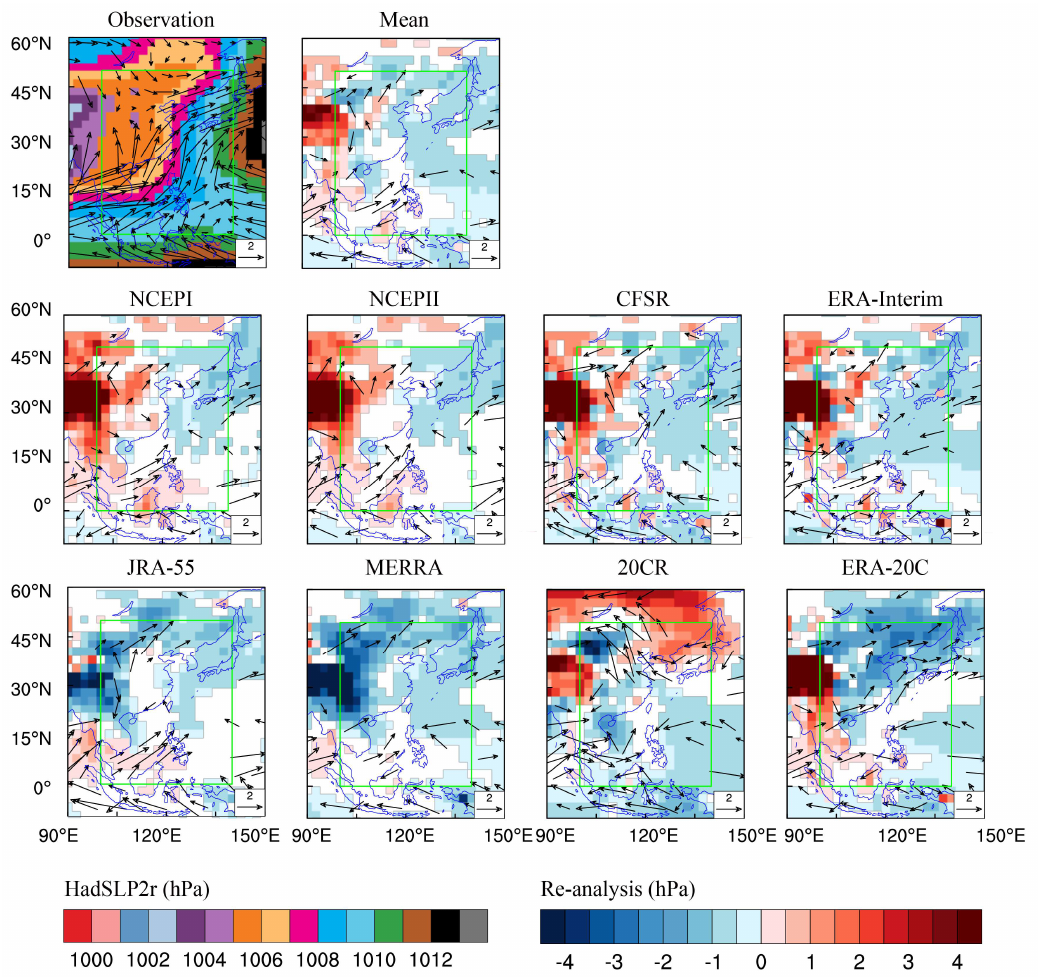
Figure 5. Summer (JJA) mean sea level pressure (observation shaded) of the extended Hadley Centre monthly historical mean sea level pressure dataset (HadSLPr2) and wind fields at 850 hPa (Observation vector) of the Integrated Global Radiosonde Archive (IGRA) and the mean sea level pressure anomalies ‘re-analysis minus HadSLPr2; shaded’, and the wind anomalies ‘re-analysis minus IGRA; vector’ in 1979–2010. The presented anomalies of precipitation pass Student’s t -test at 0.05 level. The green box represents the East Asian summer monsoon region (0–50° N, 100–140° E).